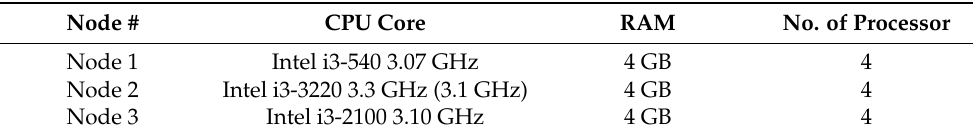
Table 1. Performance of the PCs that make up the cluster: The RAM, GHz, and number of processors that can affect simulation results were classified. Since computational performance was affected by the difference in CPU performance, the performance of Node 2 was limited in the similar way as that of other CPUs.